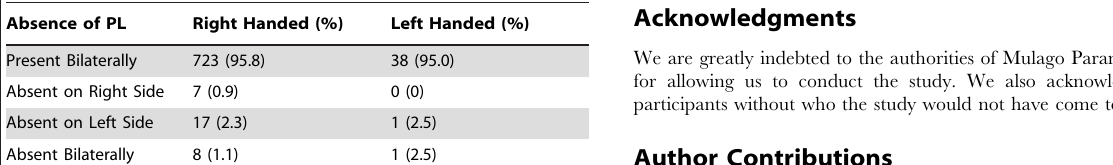
Table showing the distribution of agenesis of the PL by hand dominance of the subjects.